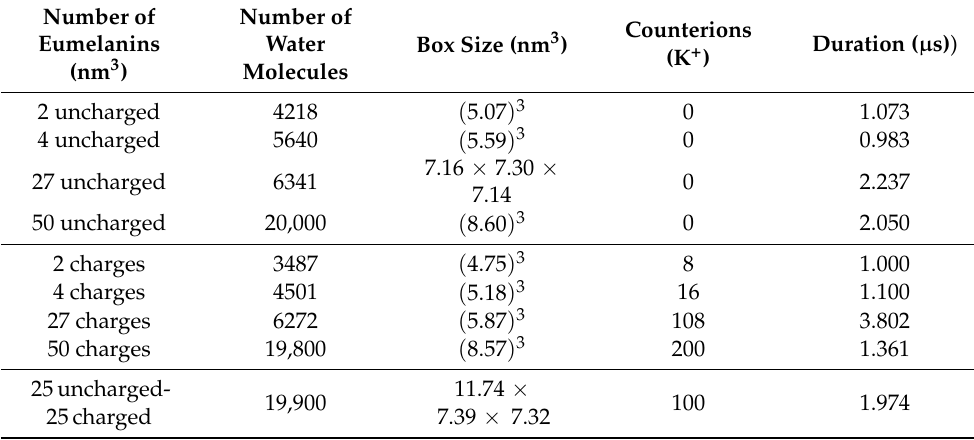
Table 1. Details of the simulated systems.